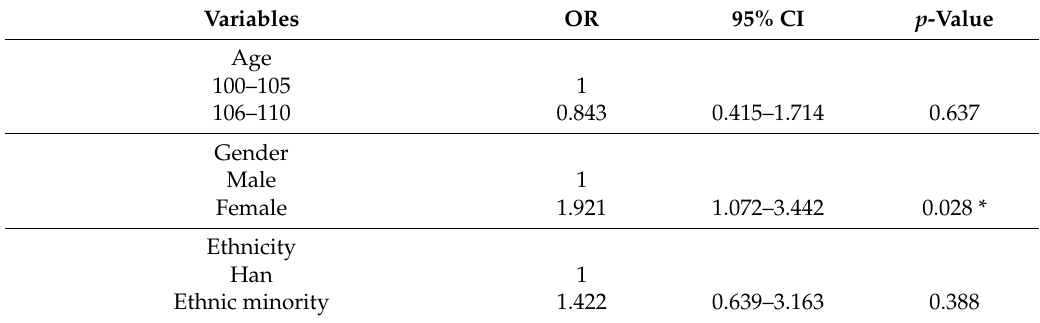
Table 3. Multivariable logistic regression analysis for the association between factors and ADL